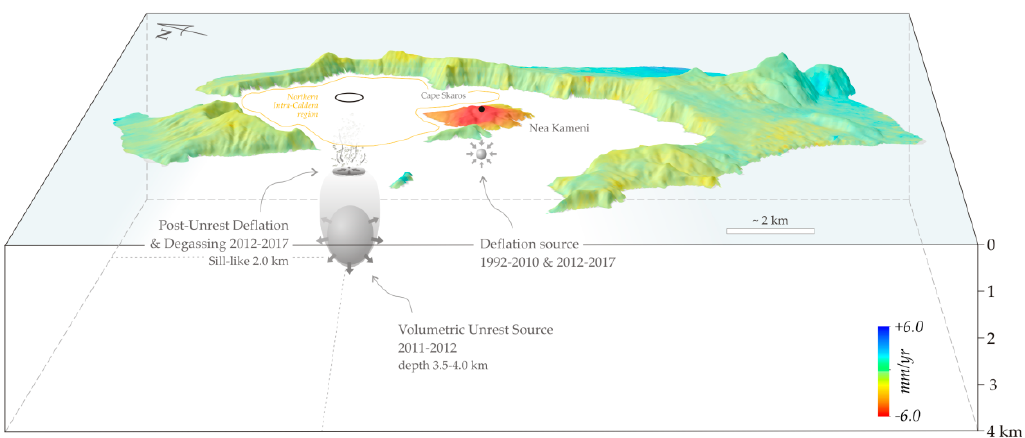
Figure 11. Schematic diagram summarizing SAR geodetic results presented herein and in Reference [4]. A shallow caldera-wide source (sill) at around 2 km depth reflects the post-unrest deflation of the deeper magma chamber responsible for the 2011–12 unrest episode. The volumetric spherical/spheroidal unrest source currently seems to undergo a depressurization due to degassing from its upper parts. A shallower deflating source (Mogi), at around 1 km depth, is also shown below Nea Kameni, exhibiting similar behavior for both the 1992–2010 pre-unrest and 2012–17 post-unrest periods.